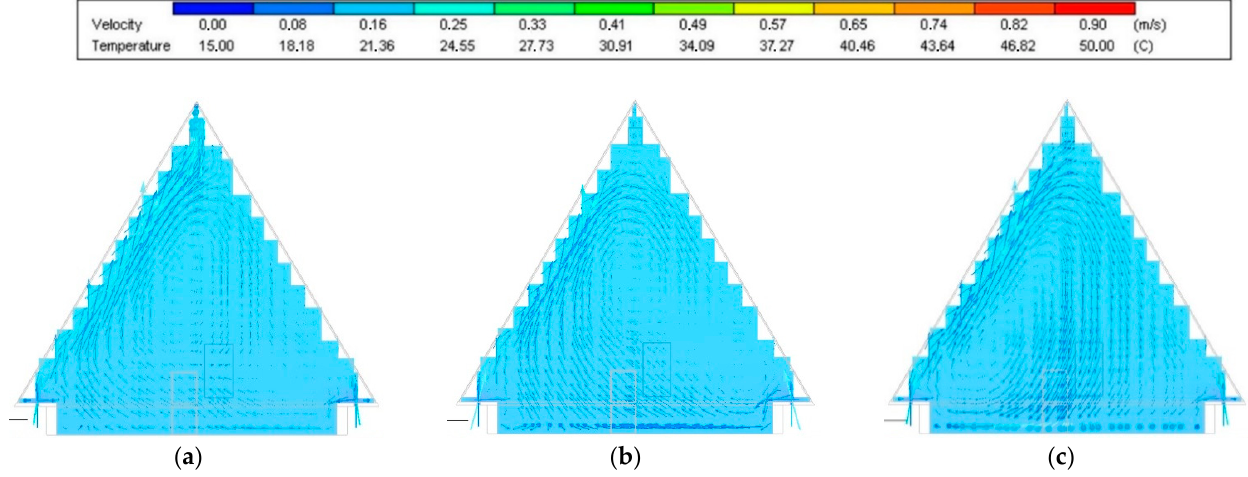
Figure 22. Simulated airflow paths on 6.6. at 6:00 a.m. in cross section: ( a ) 0.8 m from the sanctuary wall; ( b ) in the middle of attic space; ( c ) 0.8 m from the wall of the tower.